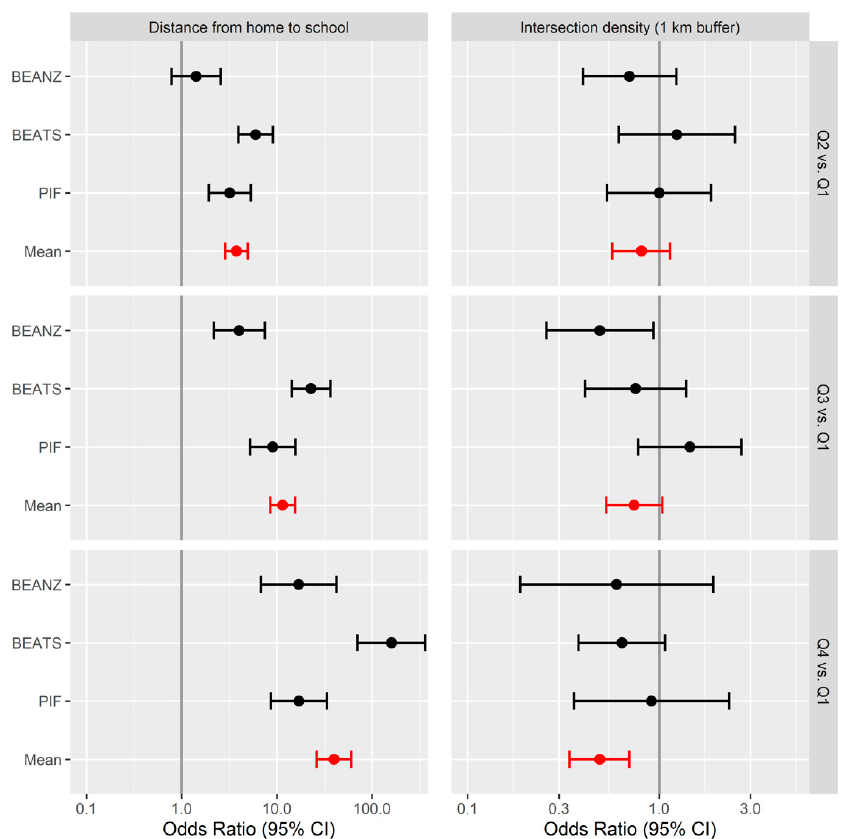
Figure 2. Forest plot comparing quartile 1 with quartiles 2, 3, and 4 for distance to school and home neighbourhood intersection density (1 km bu ff er) associations with car travel to